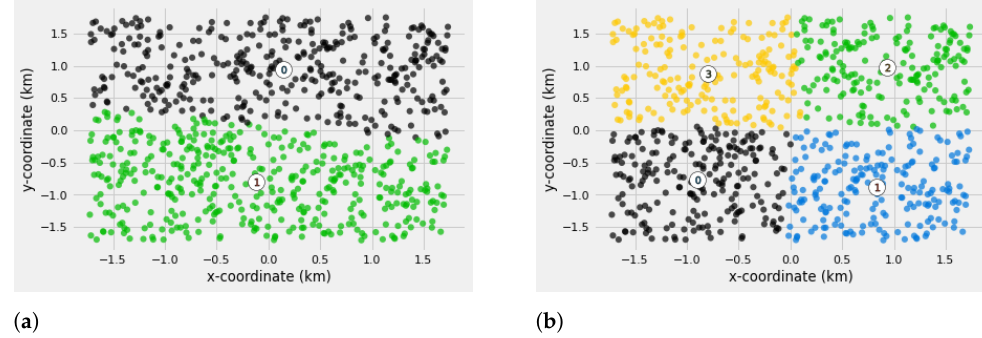
Figure 5. SM’s density ( n = 800) vs. efficient number of DAPs: ( a ) The determined structure for n = 800, when K = 2; ( b ) The determined structure for n = 800, when K =